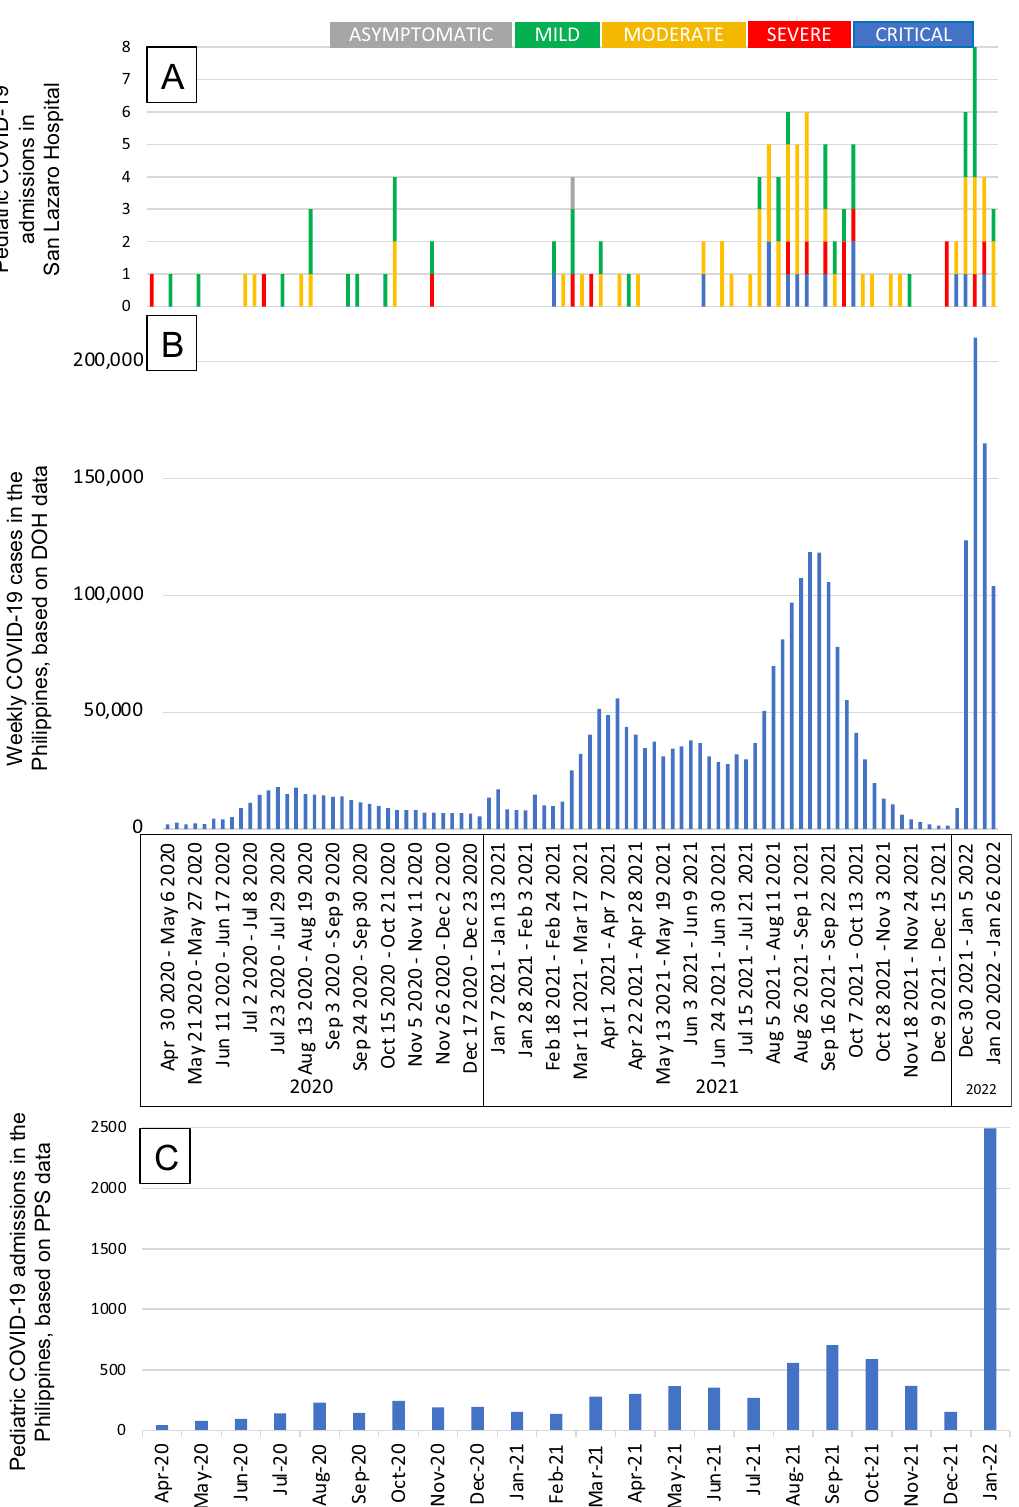
Fig. 1 Distribution of confirmed COVID‑19 cases between January 2020 and January 2022. A Pediatric COVID‑19 admissions in San Lazaro Hospital, Manila, Philippines. B Total COVID‑19 cases (all ages) in the Philippines per week, from DOH data. C Pediatric COVID‑19 admissions in the Philippines, from PPS Registry data. COVID‑19: coronavirus disease 2019; DOH: Department of Health; PPS: Philippine Pediatric